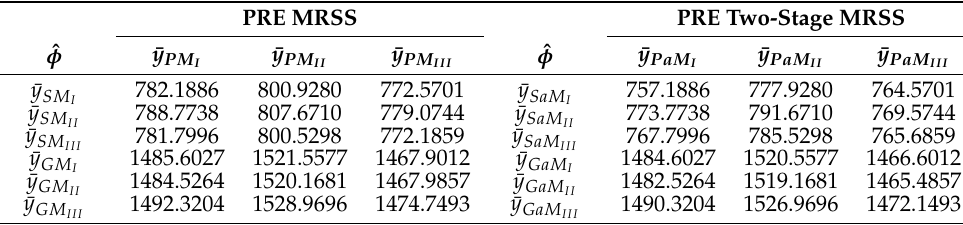
Table 8. PRE values for ( A 4 , B 4 )